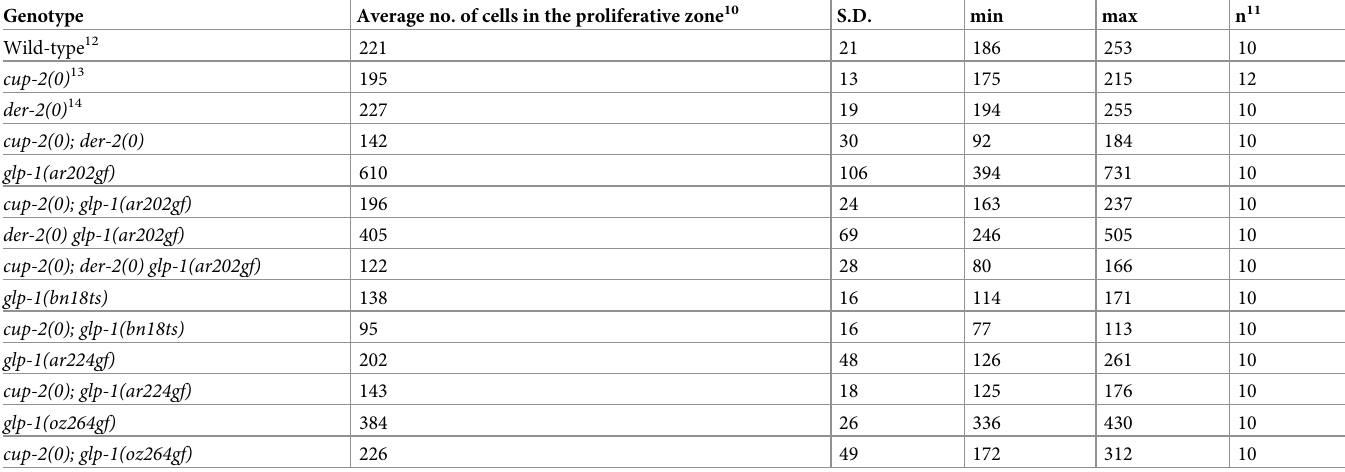
10 Proliferative cells defined as cells distal to the transition zone as identified by crescent-shaped nuclei stained by DAPI 11 Number of gonad arms for which the total number of cells in the proliferative zone were counted